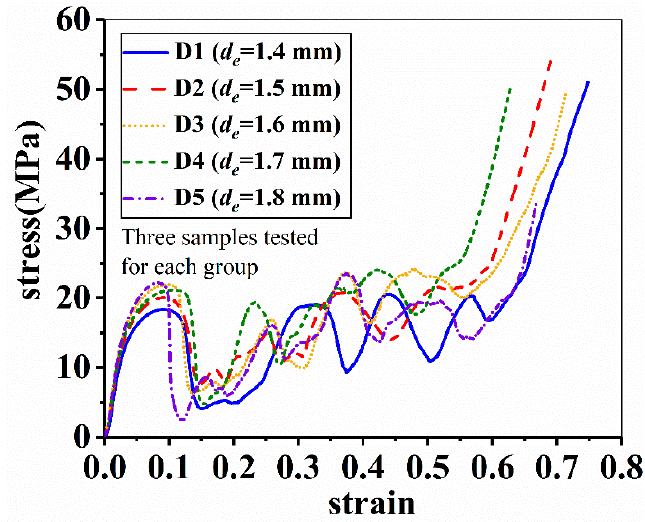
Figure 11. Effect of end diameter on the compressive stress–strain behavior of samples.